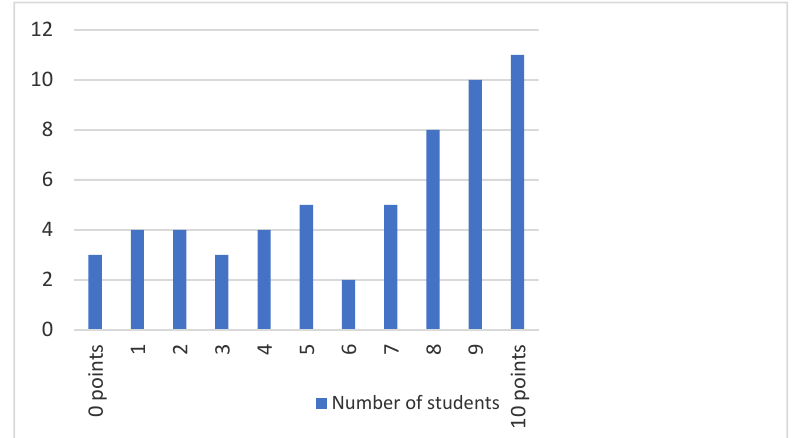
Figure 9. Results of the pre-test.